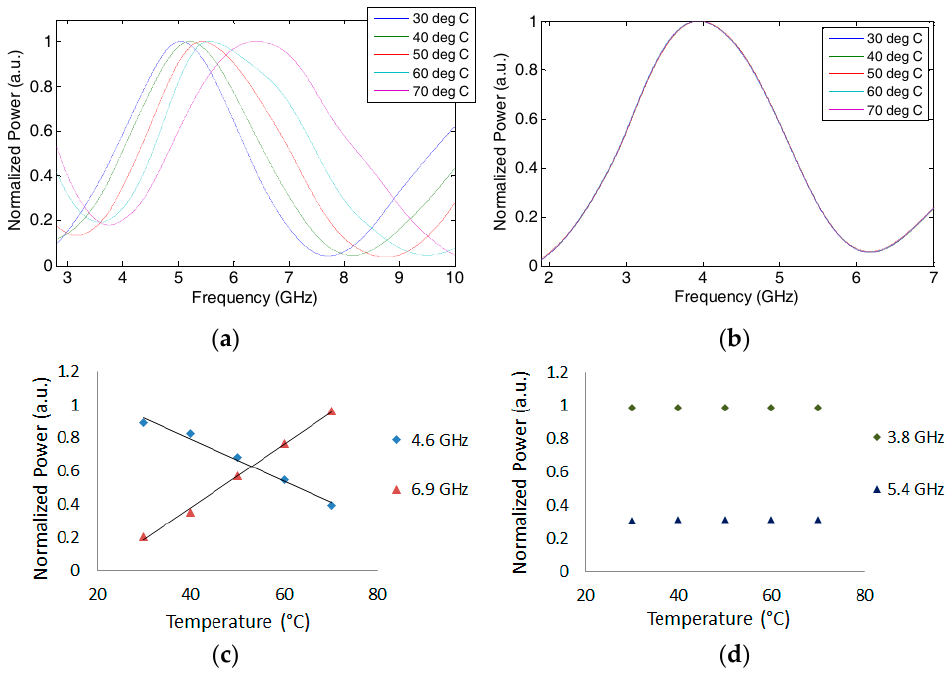
Figure 11. Characteristics of Sensor 2 as the temperature is increased from 30 °C to 70 °C, while Sensor 1 is maintained at a constant (room) temperature. MWP filter responses for Sensor 2 ( a ) and Sensor 1 ( b ) and corresponding normalized RF power vs. temperature at frequencies of 4.6 GHz and 6.9 GHz (for Sensor 2) and 3.8 GHz and 5.4 GHz (for Sensor 1).